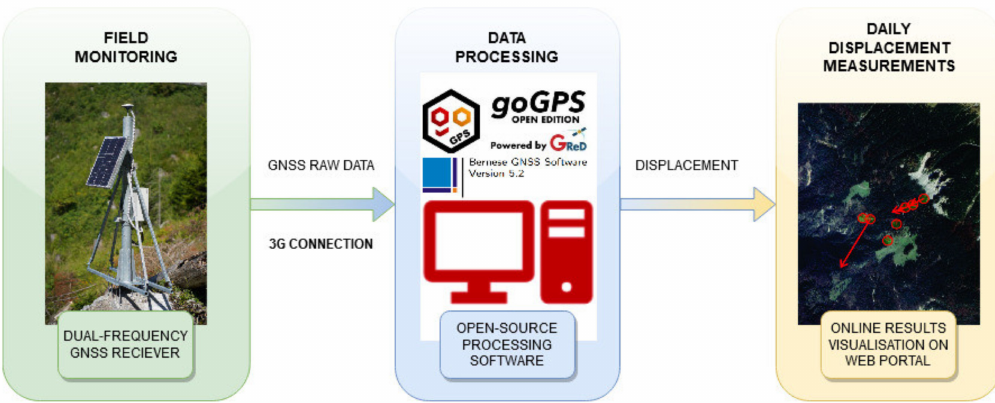
Figure 3. Workflow of the GNSS (Global Navigation Satellite System) component of GIMS (Geodetic Integrated Monitoring System)